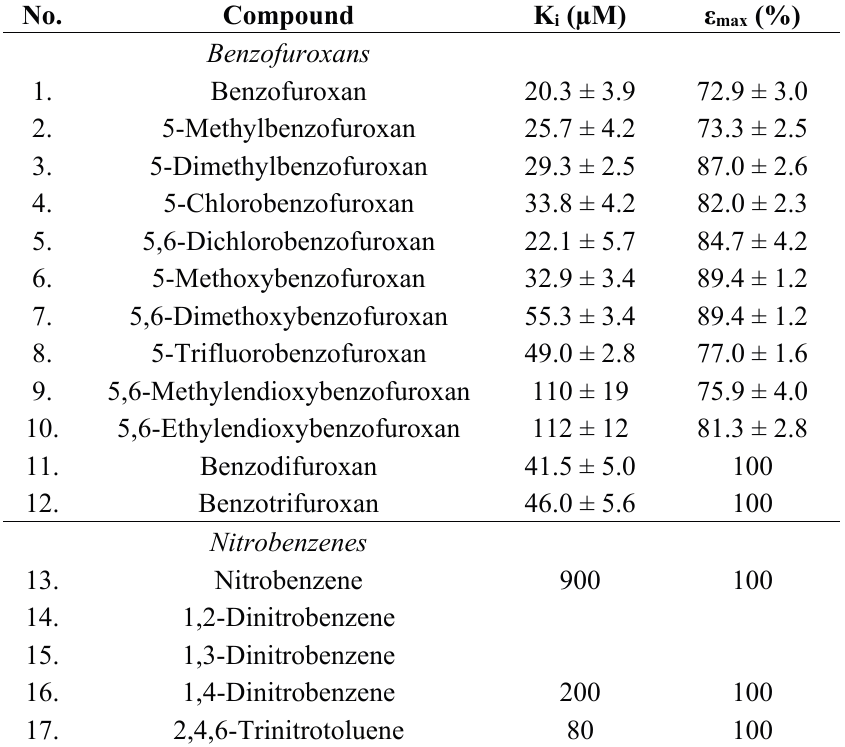
Table 4. Inhibition constants (K i ) and the maximal degrees of inhibition ( ε max ) of NQO1 by BFXs and NACs. K i values of NQO1 by NACs are taken from [20].